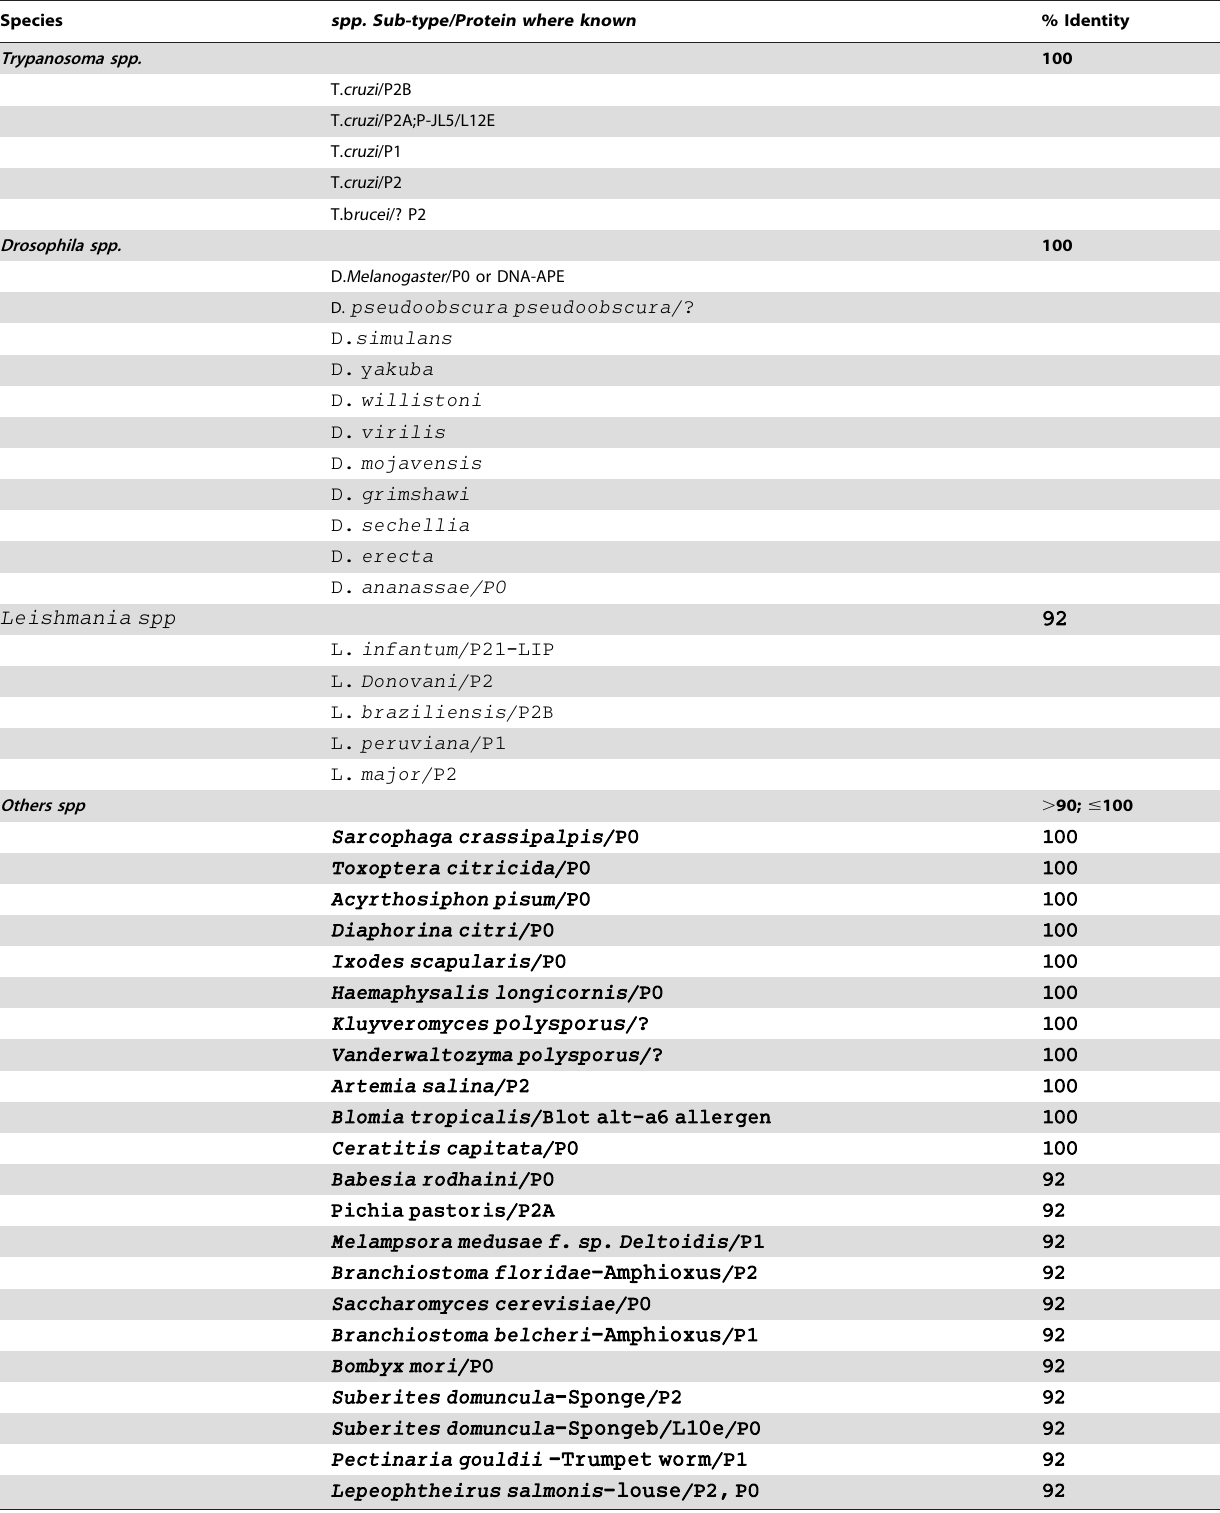
Table 2. List of Eukaryota spp. with homologous sequences to TcP2B.